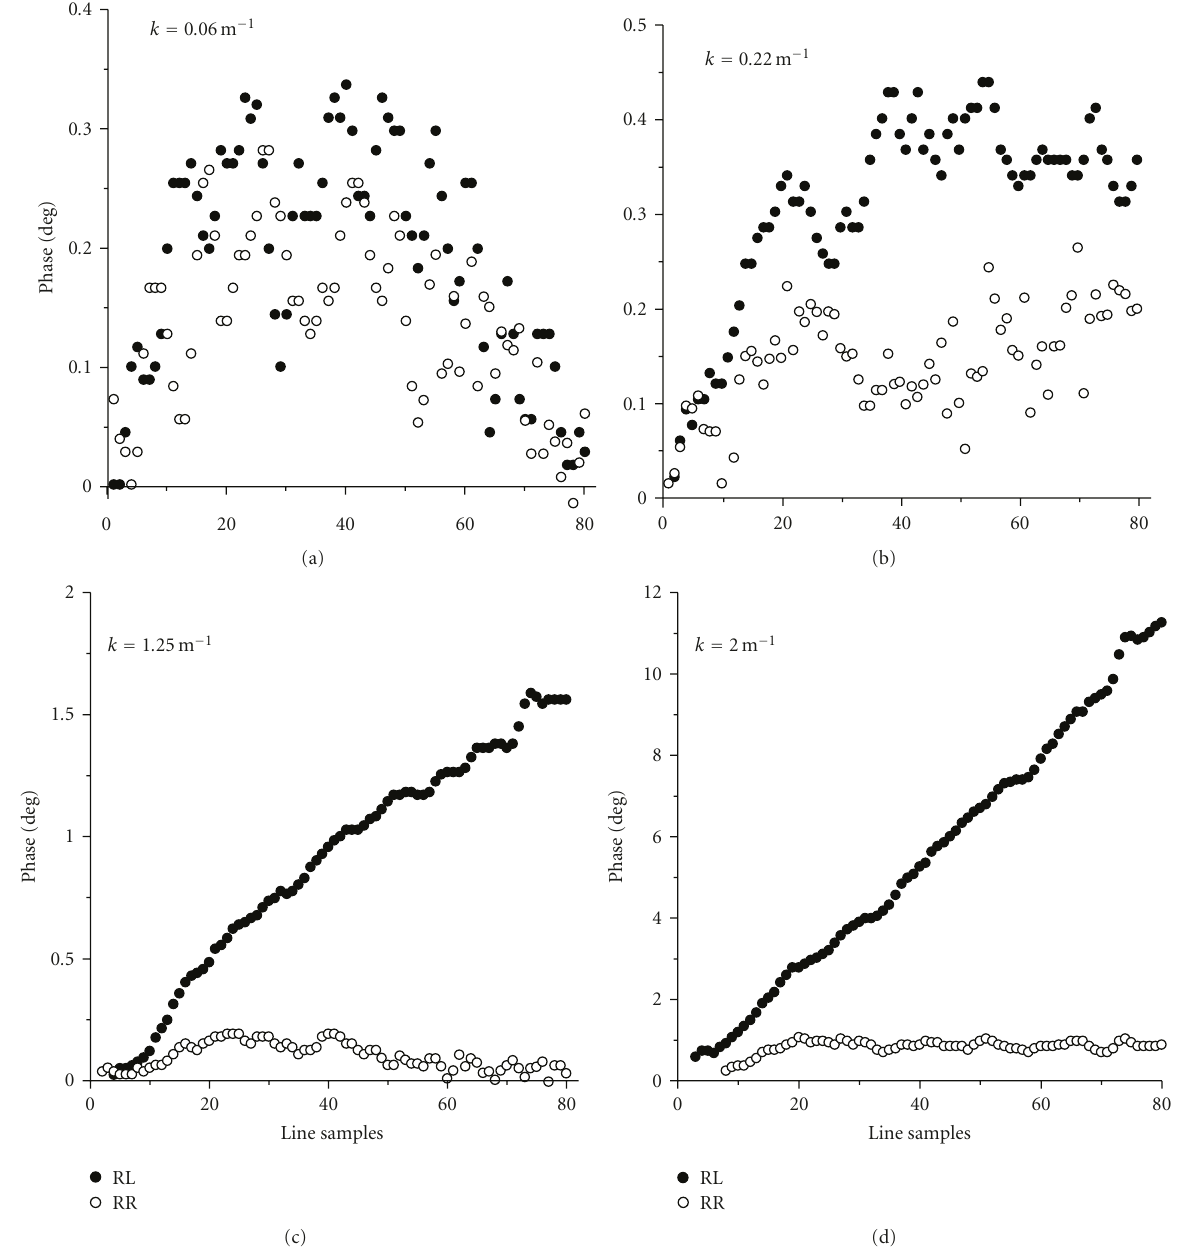
Figure 11: Linear phase profiles of a flat metallic target (z T = 1 . 56m) corresponding to RL (filled circles) and RR (open circles) schemes, for water of various turbidity levels. The AM laser beam ( f m = 39MHz) was in right-handed circular polarization